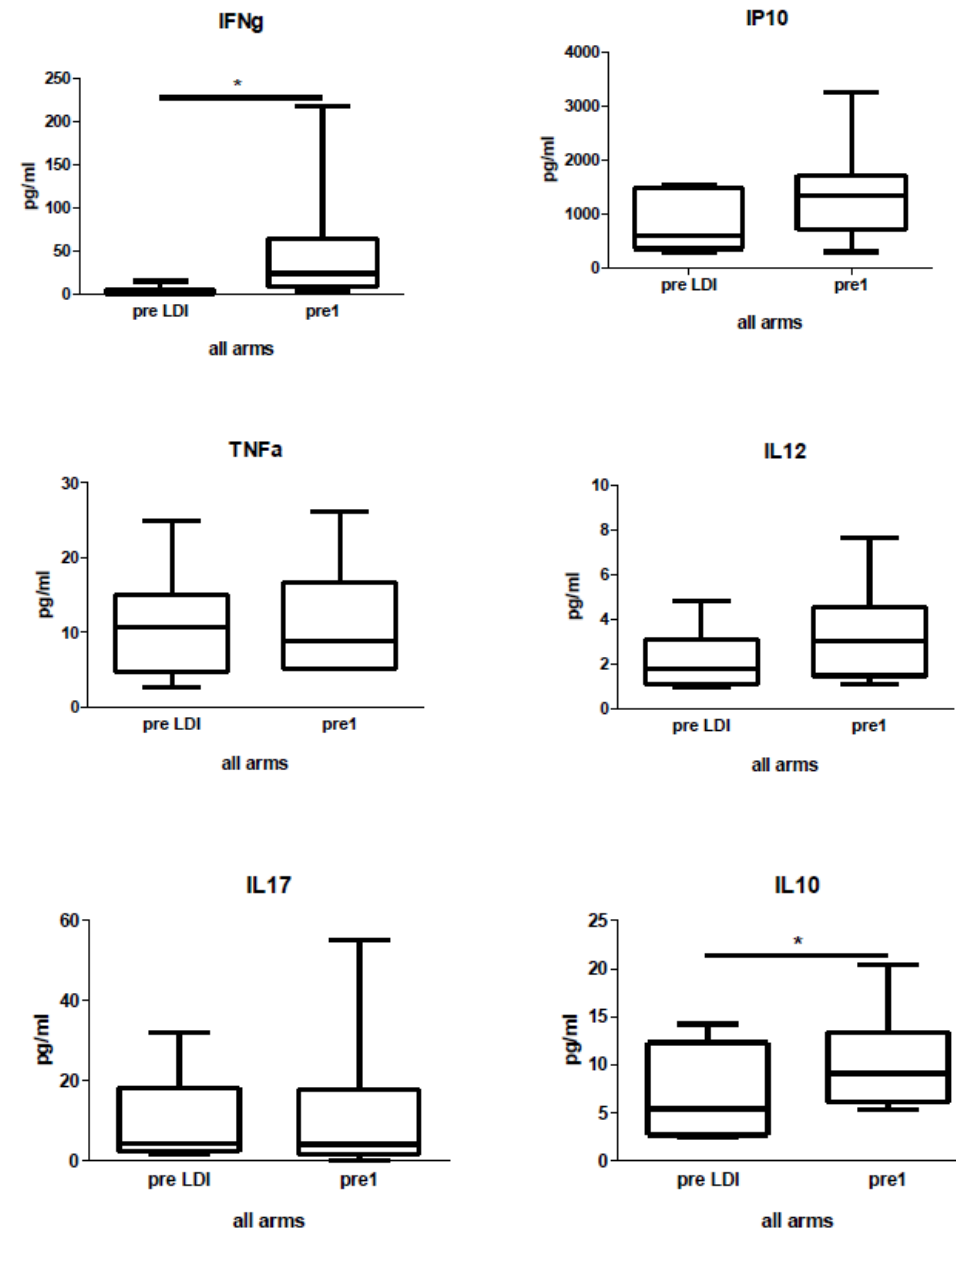
Figure 4. Cytokine level in the serum of patients before and after low-dose of IFN. The serum of 17 patients was analyzed, * p <